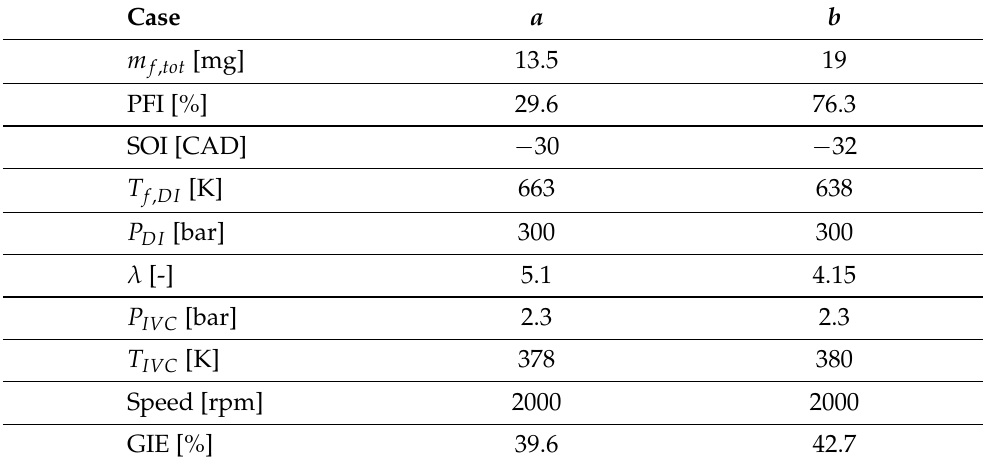
Table 3. Operating condition specifications as initial and boundary conditions for CFD calculations.